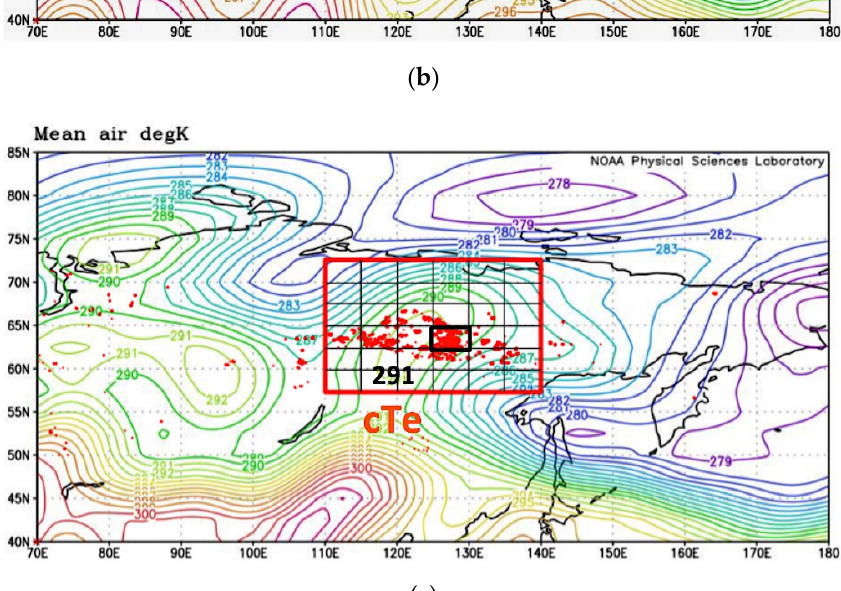
Figure 6. ( a ) Temperature map on 24 July. See captions for Figure 4, ( b ) Largest peak on 2 August. See captions for Figure 4, ( c ) Largest peak on 7 August. See captions for Figure 4.